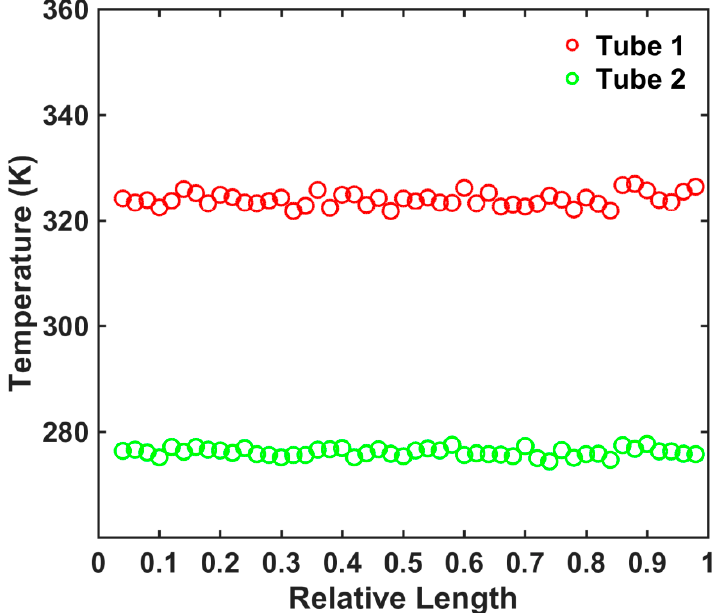
Figure 2. Typical temperature profile of the two single-walled carbon nanotubes (SWCNTs) in a single thermal contact.